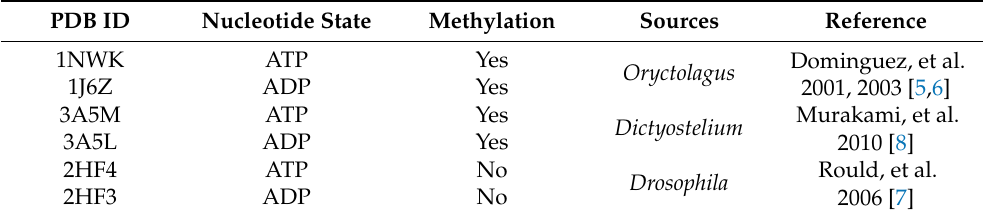
Table 3. The structural information of the selected actin structures in Pi release mechanisms analysis. PDB ID Nucleotide State Methylation Sources